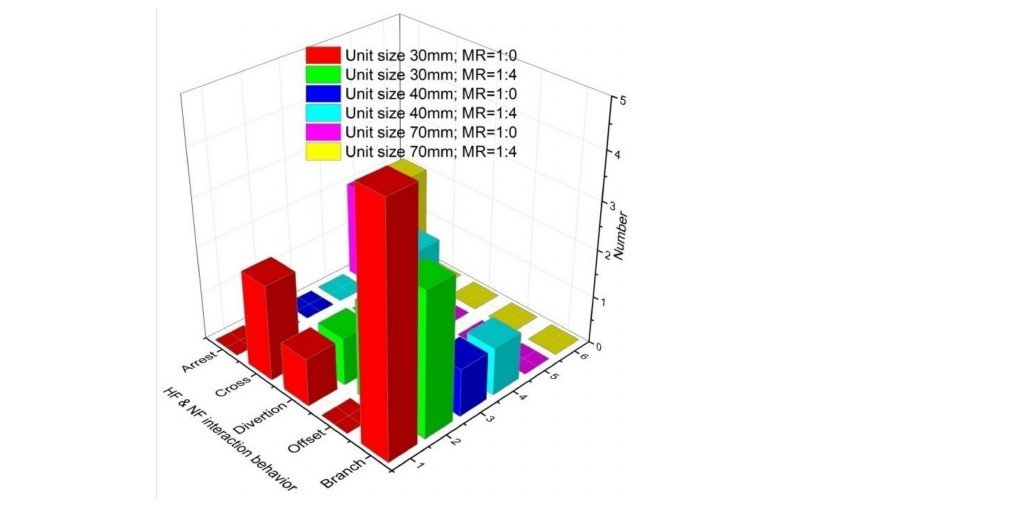
Figure 9. Statistical result of the interactions between NFs and HFs (main mechanical behaviors include cross, branch, diversion, offset and arrest).